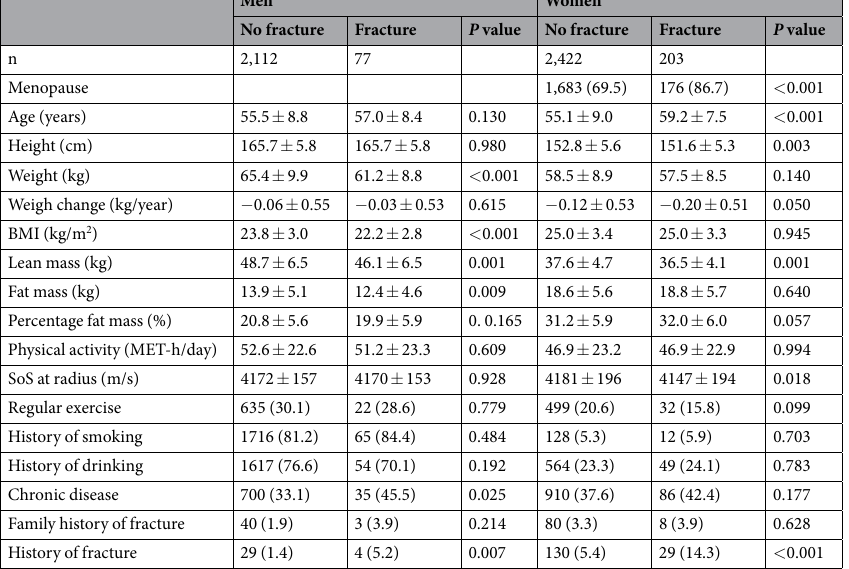
Table 3. Baseline risk factors and body composition in men and women without and with incident fragility fractures. Values are means ± SD or n(%). LM, lean mass; PF, percentage body fat; BMI, body mass index; MET, metabolic equivalent; SoS, speed of sound. Weight change (in kg) was calculated as the difference between weight at the last follow-up and that at the first visit divided by the follow-up years. Incident fractures were documented during the follow-up period from 2000 to